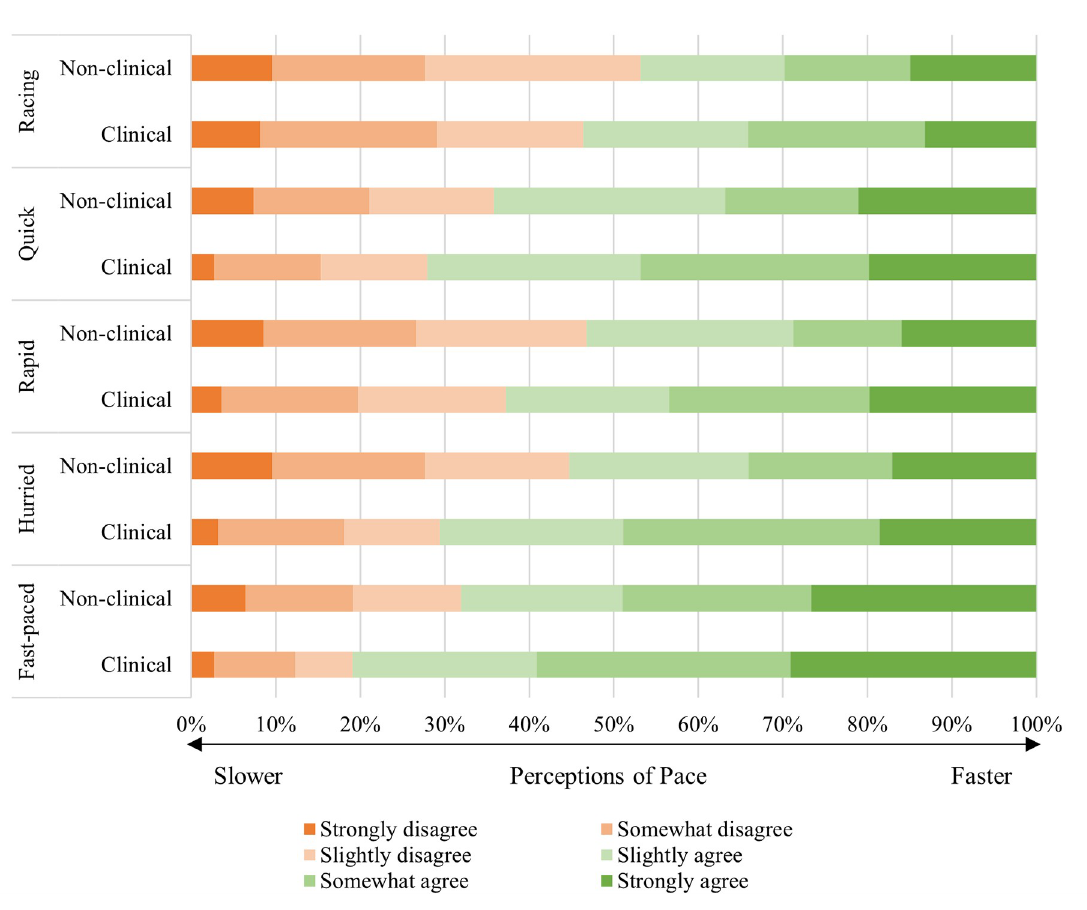
Fig 2. Perceptions of hospital pace: Clinical vs. non-clinical